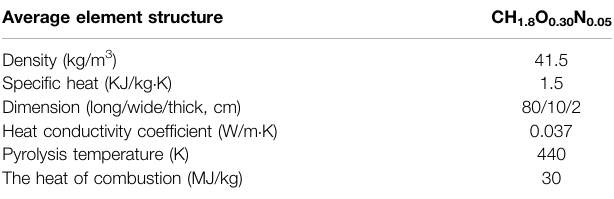
TABLE 1 | Properties of the FPU foam used for tests. Average element structure